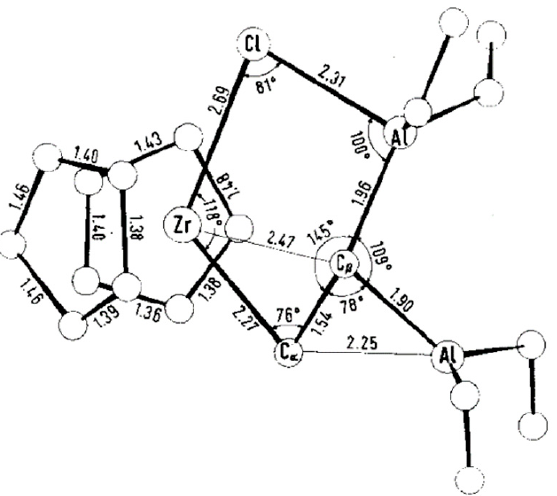
Figure 14. Molecular structure of Zr13 . Reprinted with permission from [147]. Copyright (1974) Wiley-VCH Verlag GmbH & Co. An interesting complex, Zr15 with a Zr–( µ -Cl)–Al fragment, was formed as a result of the reaction of the Cp 2 Zr buta-1,3-diene complex with Me 2 AlCl (Scheme 20) [153].